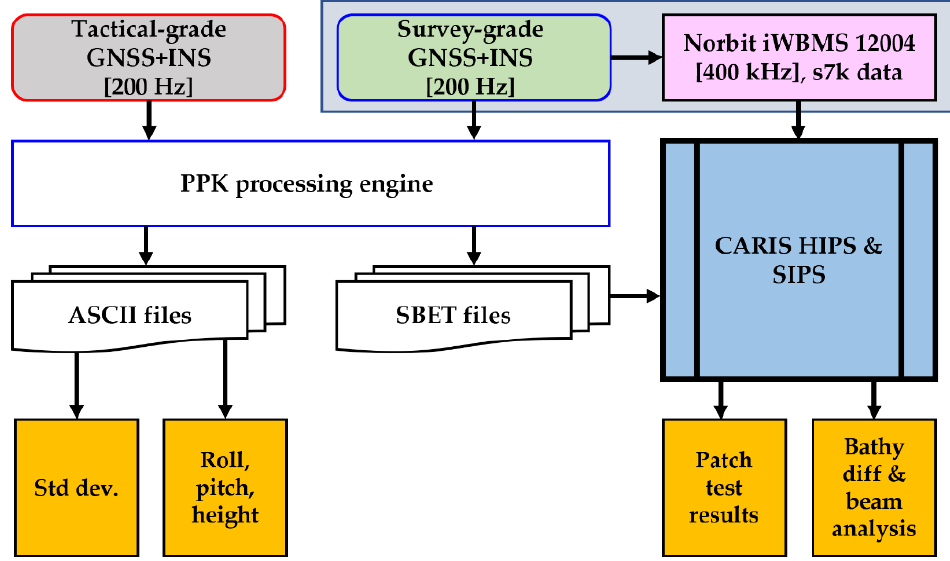
Figure 3. Data processing (PPK) and analysis overview — navigation results uncertainties; roll, pitch, elevations, patch test results, and bathymetric data comparison between systems offer insight into systems’ performances.